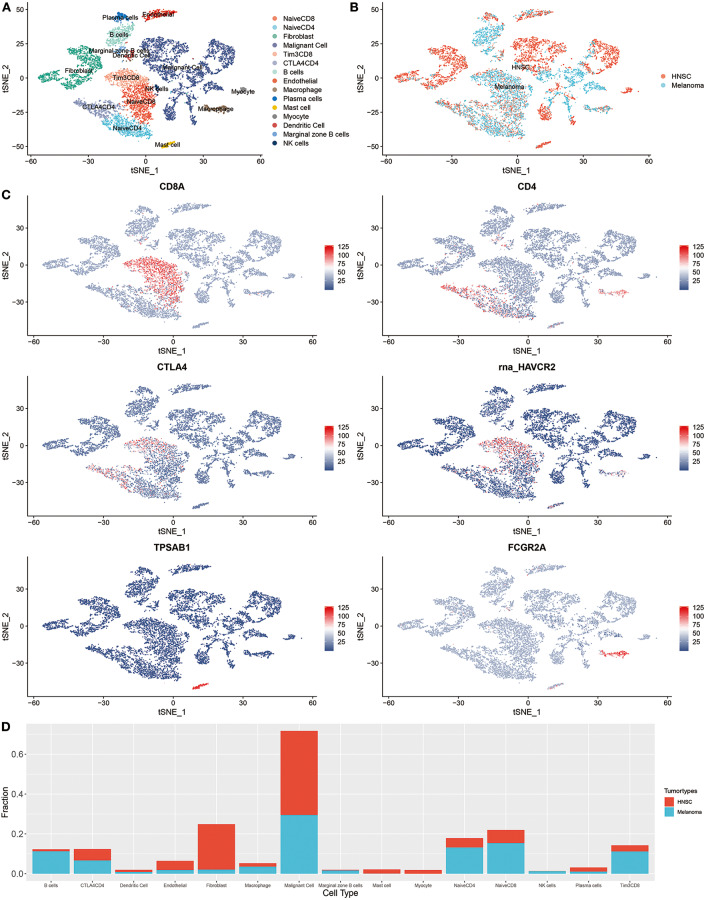
Integrated single-cell RNA sequencing analysis revealed the microenvironment heterogeneity of distant tumor types. (A) The t-SNE plot displays immunological and non-immunological cells in the tumor microenvironment. Each dot represents a cell and color represents different types of cells. (B) The color was coded according to tumor types. (C) The expression of cell markers across different cell clusters. (D) The composition of cells in HNSC and melanoma.